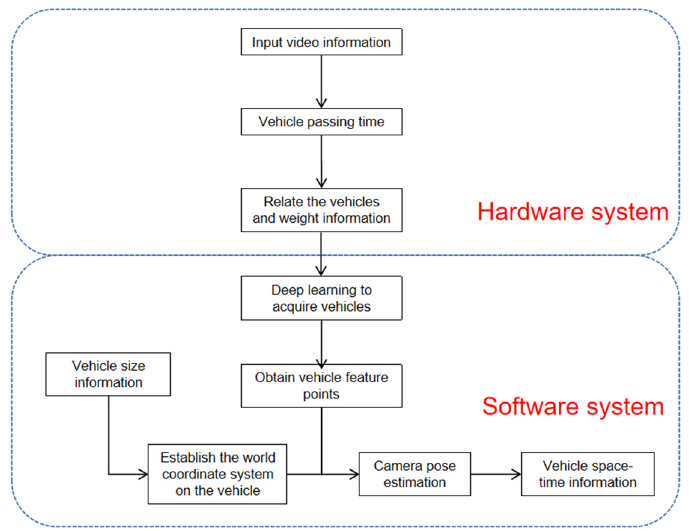
Figure 1. Framework of the proposed method.